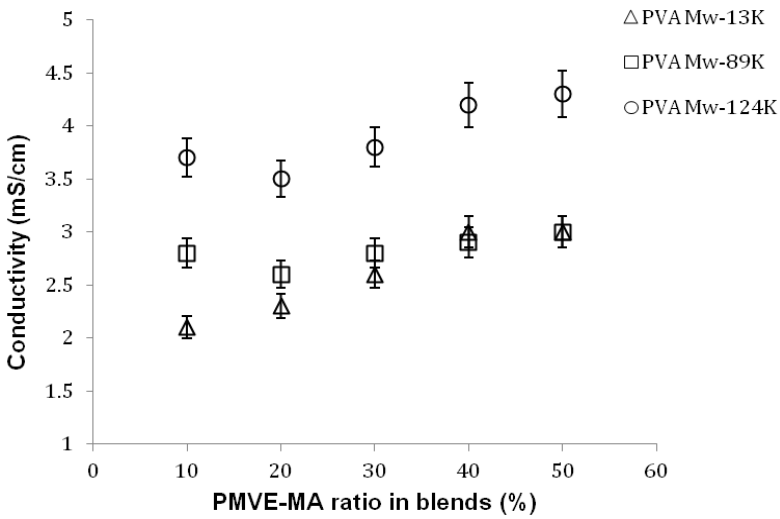
Figure 7. Effect of PMVE-MA ratio and PVA molecular weight on the conductivity of the blend membranes. Values are means ±